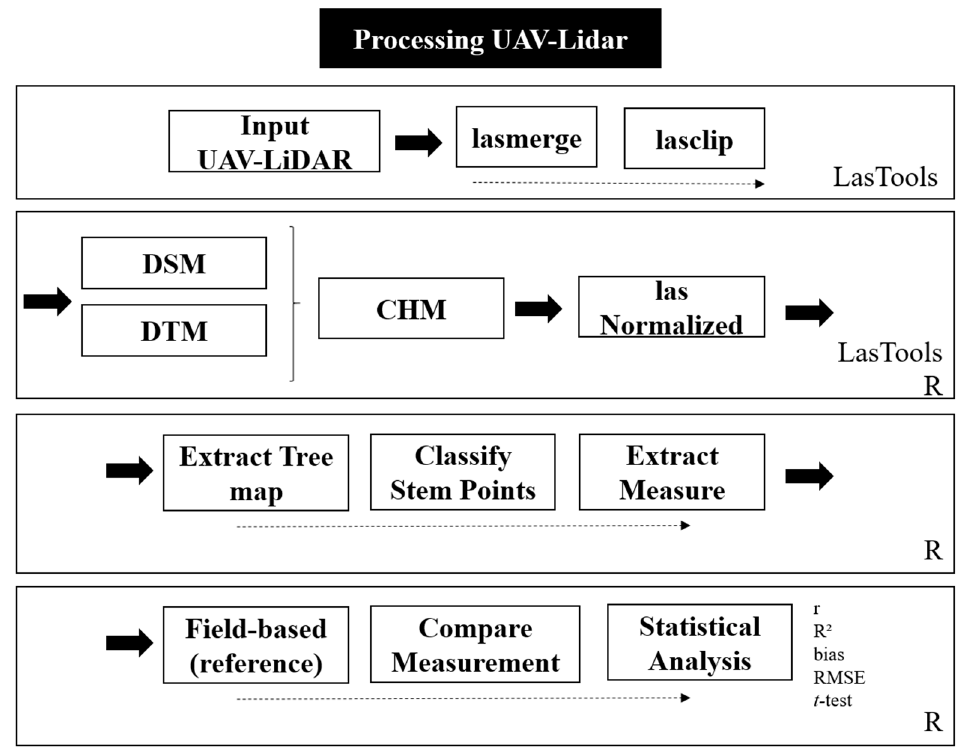
Figure 2. Procedure for processing the cloud point and estimation of forest inventory parameters mensuration.